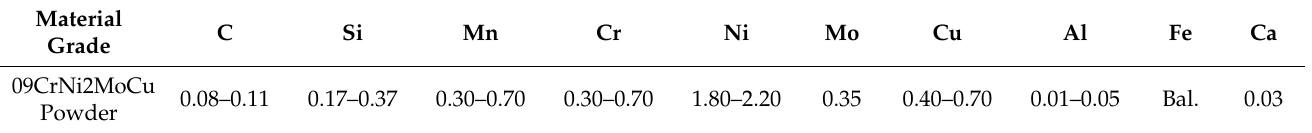
Table 1. The chemical composition of the 09CrNi2MoCu